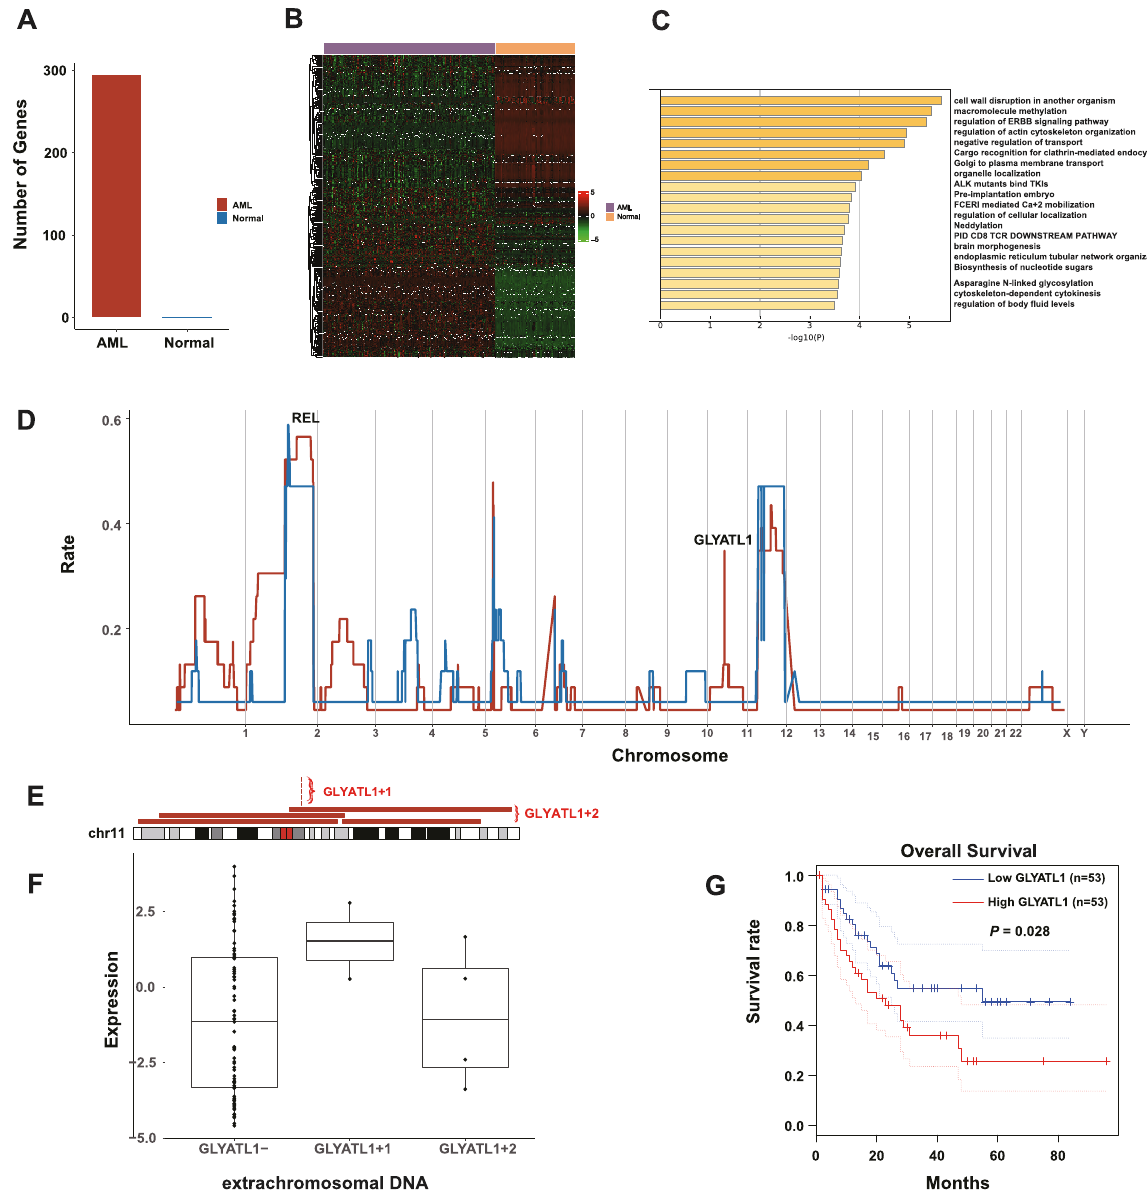
Fig. 7 The comparison of eccDNA in AML cells (containing pHSC, LSC, and blast) and normal cells (including B cell, CD4 + T cell, CD8 + T cell, CLP, Ery, MEP, Mono, and NK cell). A The number of peculiar genes on eccDNA of AML cells is far more than normal cells. B Heatmap showed the cluster analysis of the different expressed AML-speci fi c and normal-speci fi c genes. The horizontal axis represents different genes, and the vertical axis represents AML or normal hematopoiesis. C GO enrichment of differential expressed genes on eccDNA of AML. D The rate of eccDNA in AML and normal cells. E Different lengths of eccDNA containing GLYATL1 . GLYATL1 + 1 represented shorter eccDNA that contain GLYATL1 , GLYATL1 + 2 represented longer eccDNA that contain GLYATL1. GLYATL1 - represented eccDNA that doesn ’ t contain GLYATL1 . F The GLYATL1 + 1 expressed higher GLYATL1 , and the expression of GLYATL1 in the GLYATL1 + 2 was almost the same as that of GLYATL1 - (The P value was not signi fi cant). G The high expression of GLYATL1 predicted shorter OS ( P =